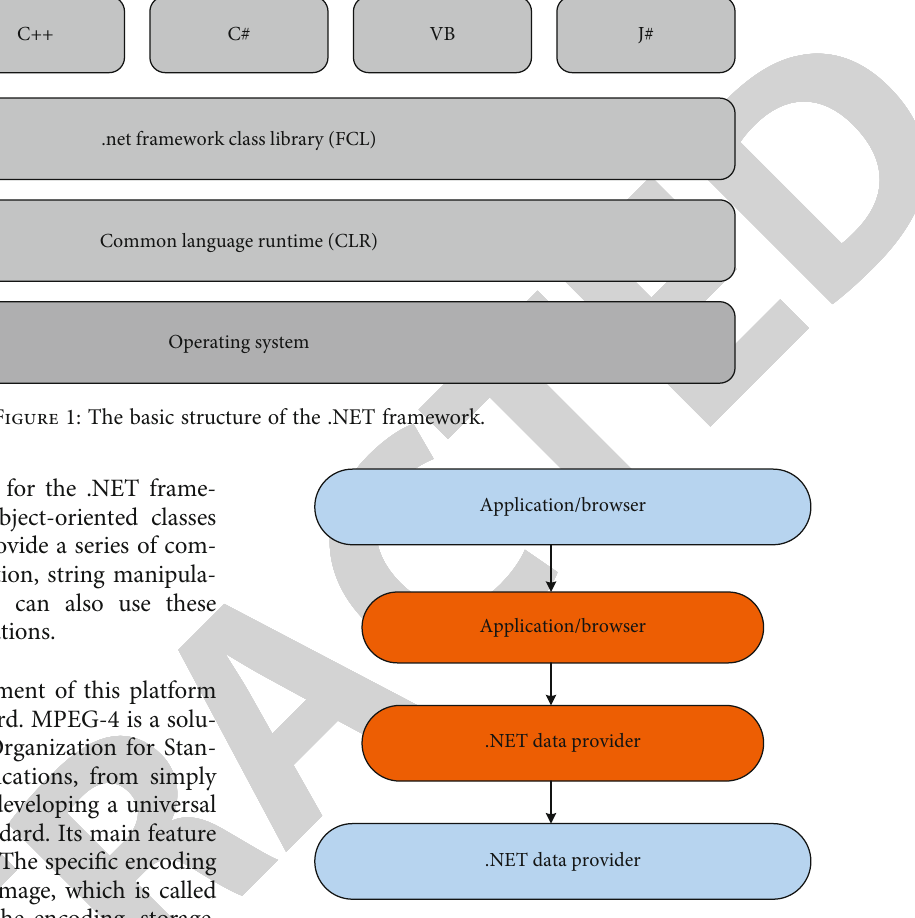
Figure 2: ADO.NET